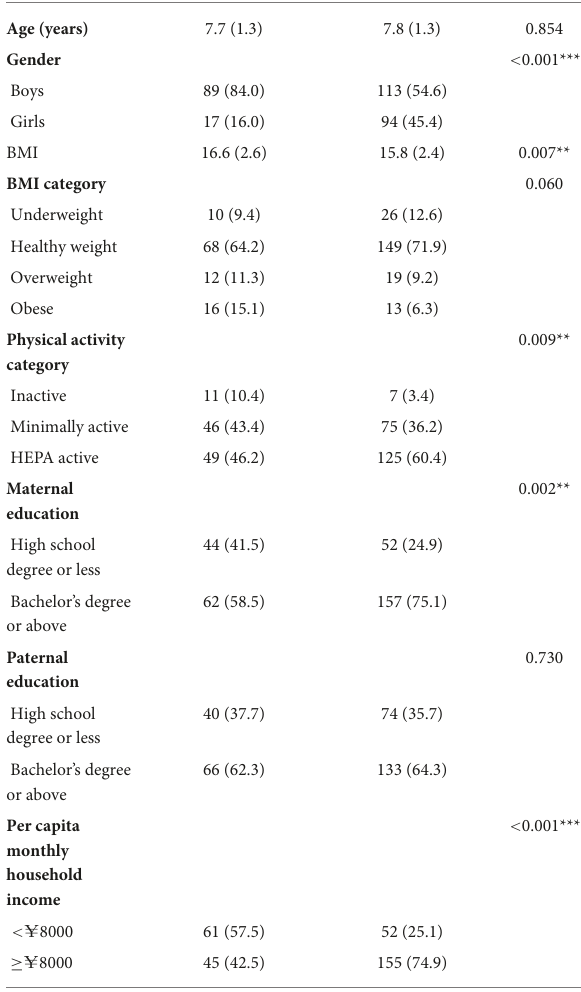
TABLE 1 Demographic characteristics of children with ASD and TD